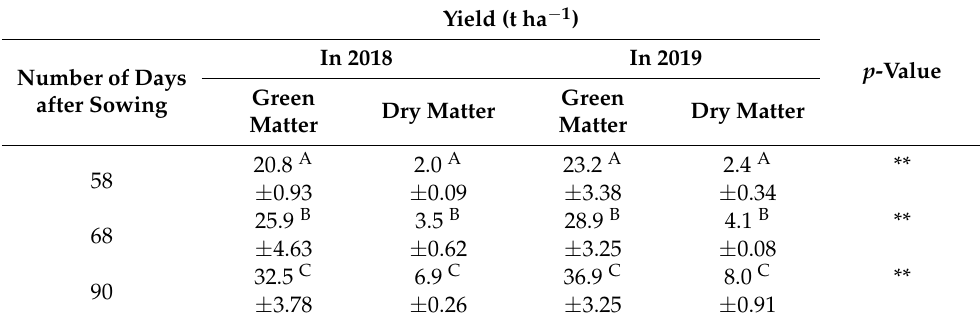
Table 2. Effect of harvesting date on green fodder yield (mean ± SD for harvest date) ( n = 10). Yield (t ha − 1 ) In 2018 In 2019 p -ValueNumber of Days Green Green after Sowing Dry Matter Dry Matter Matter Matter 20.8 A 2.0 A 23.2 A 2.4 A ** 58 ± 0.93 ± 0.09 ± 3.38 ± 0.34 25.9 B 3.5 B 28.9 B 4.1 B ** 68 ± 4.63 ± 0.62 ± 3.25 ± 0.08 32.5 C 6.9 C 36.9 C 8.0 C ** 90 ± 3.78 ± 0.26 ± 3.25 ±